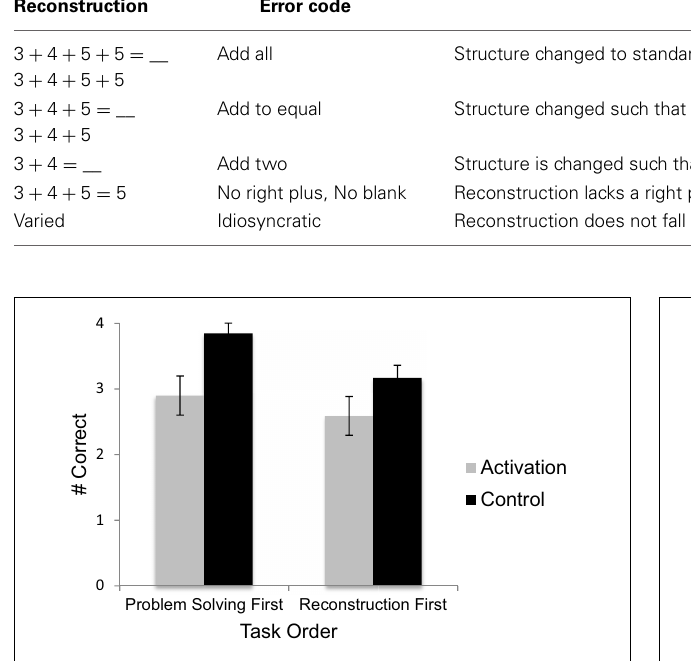
FIGURE 1 | Performance on the problem reconstruction task by task order and condition. Error bars represent ± 1 standard error.